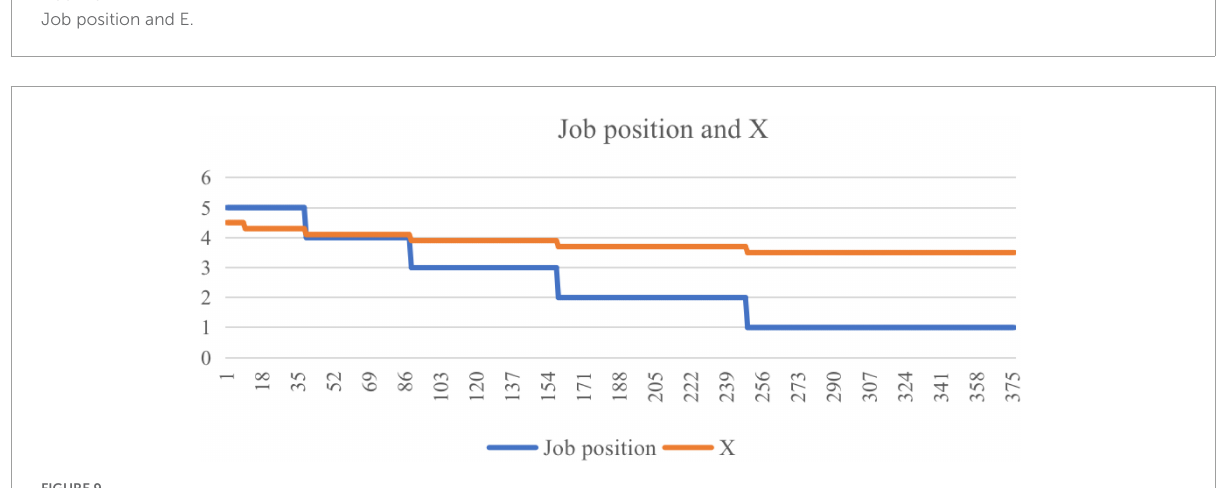
FIGURE8 Job position and E.